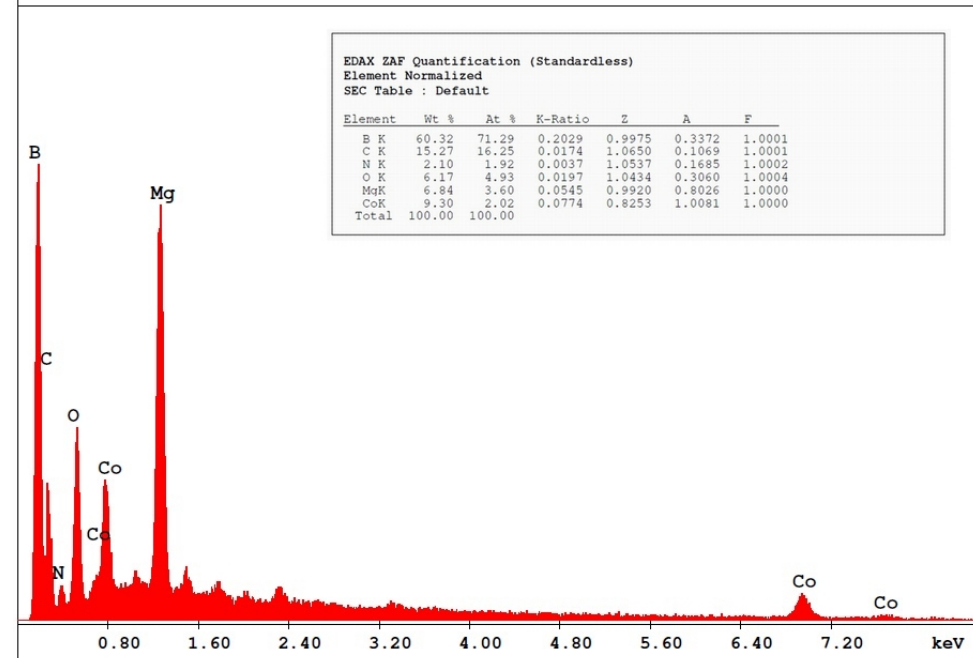
Figure 2. Energy-dispersive X-ray spectroscopy (EDS, EDX) results of Co2B NPs show the atomic Figure 2. Energy ‐ dispersive X ‐ ray spectroscopy (EDS, EDX) results of Co2B NPs show the atomic ratios of Co/B (at %). ratios of Co/B (at %).